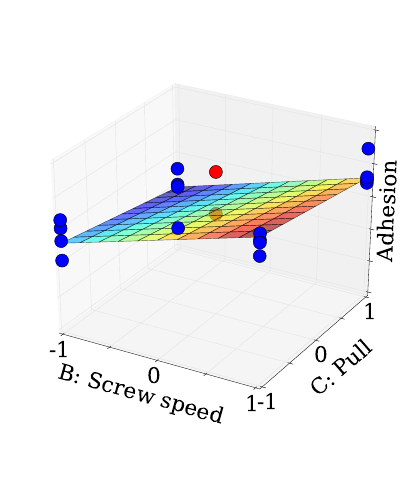
Figure 13: Adhesion first response surface